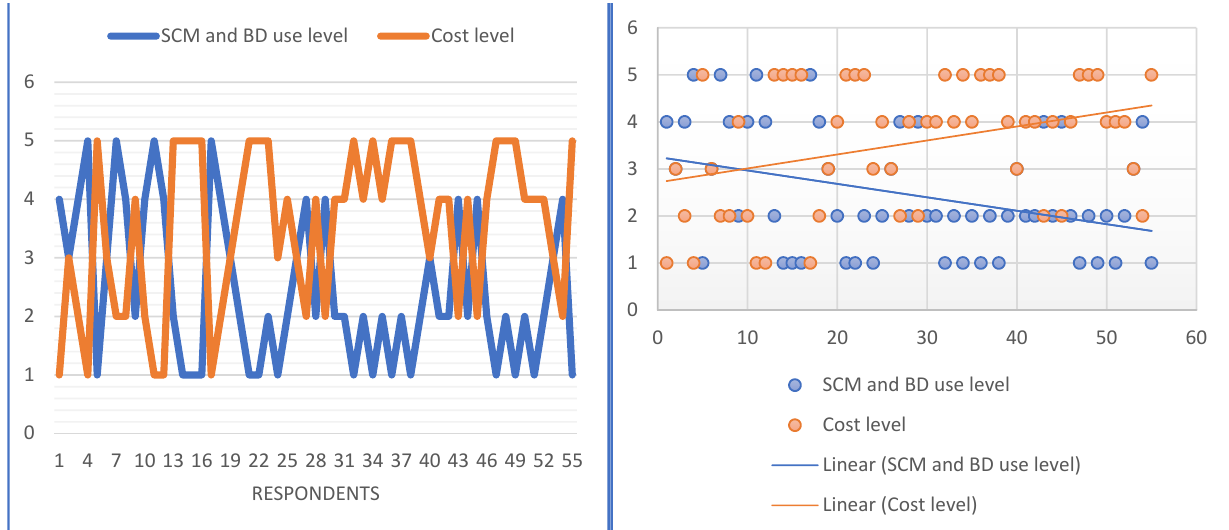
Figure 7. ( left ) Correlation between the examined variables (level of SCM and BD usage and cost level) and ( right ) linear correlation between variables.